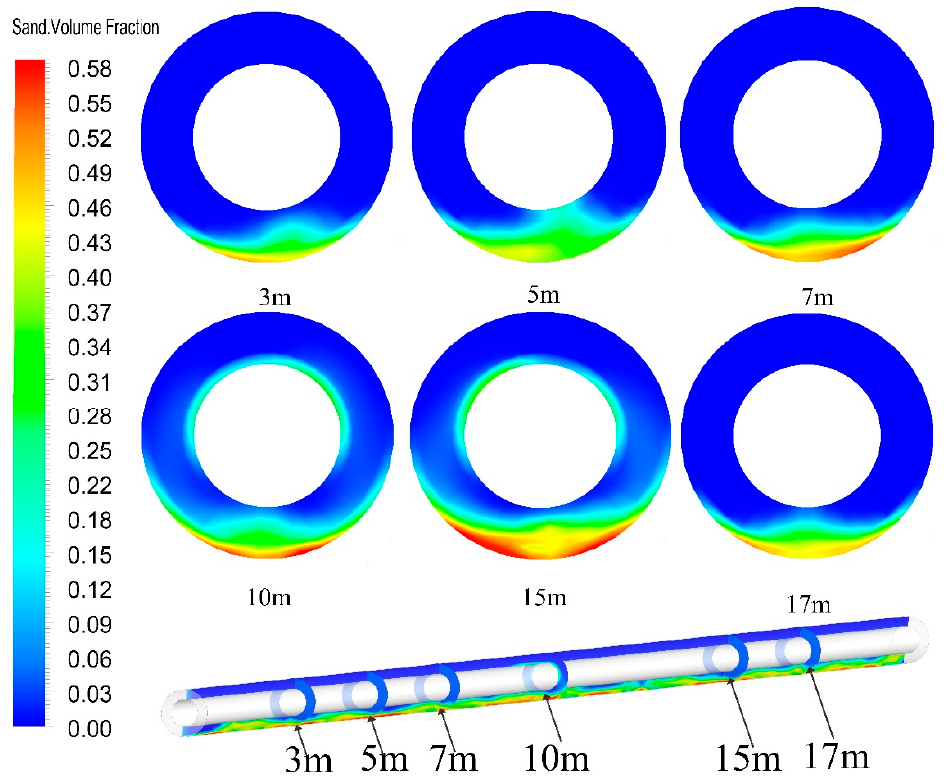
Figure 8. The contour of volume fraction for pulsed gravel packing in horizontal wells.